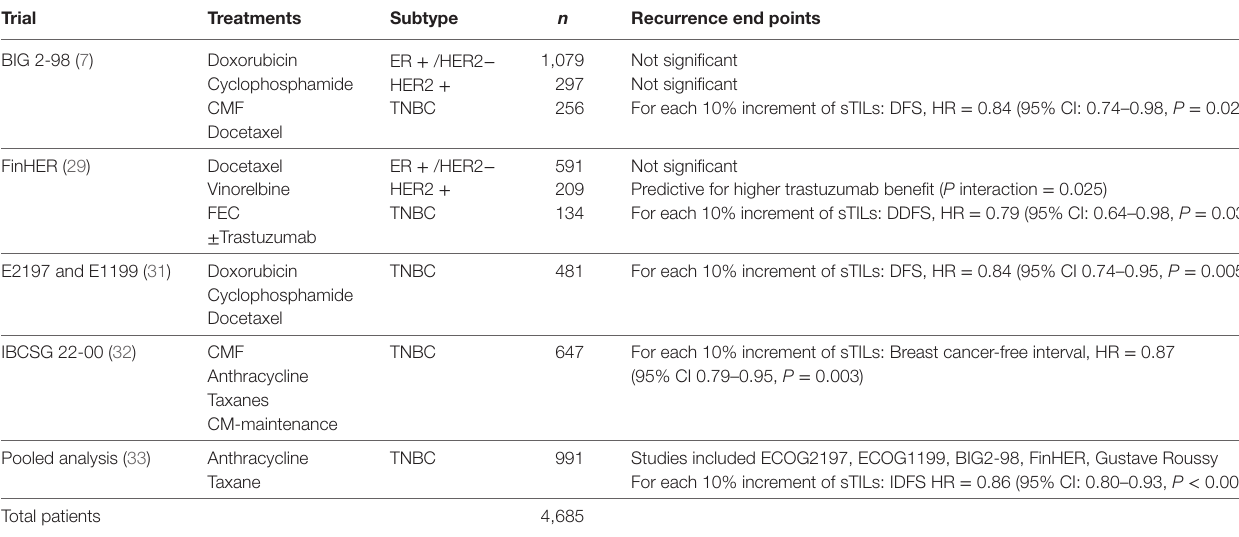
TABLe 1 | Adjuvant trials that have assessed tumor-infiltrating lymphocytes (TILs).